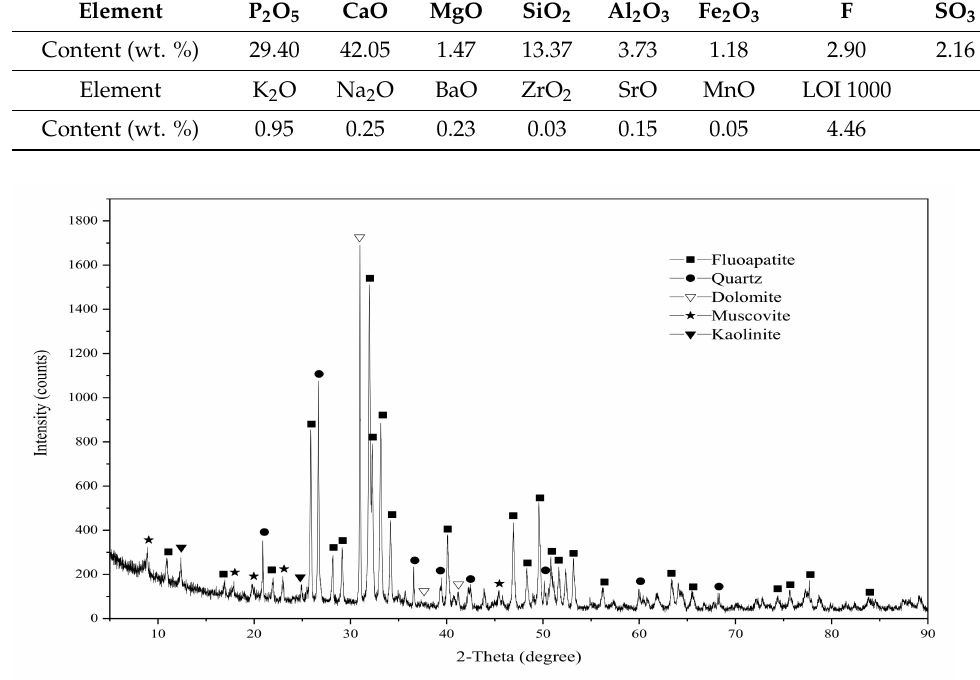
Figure 1. XRD spectra of collophanite with particle size of − 45 µ